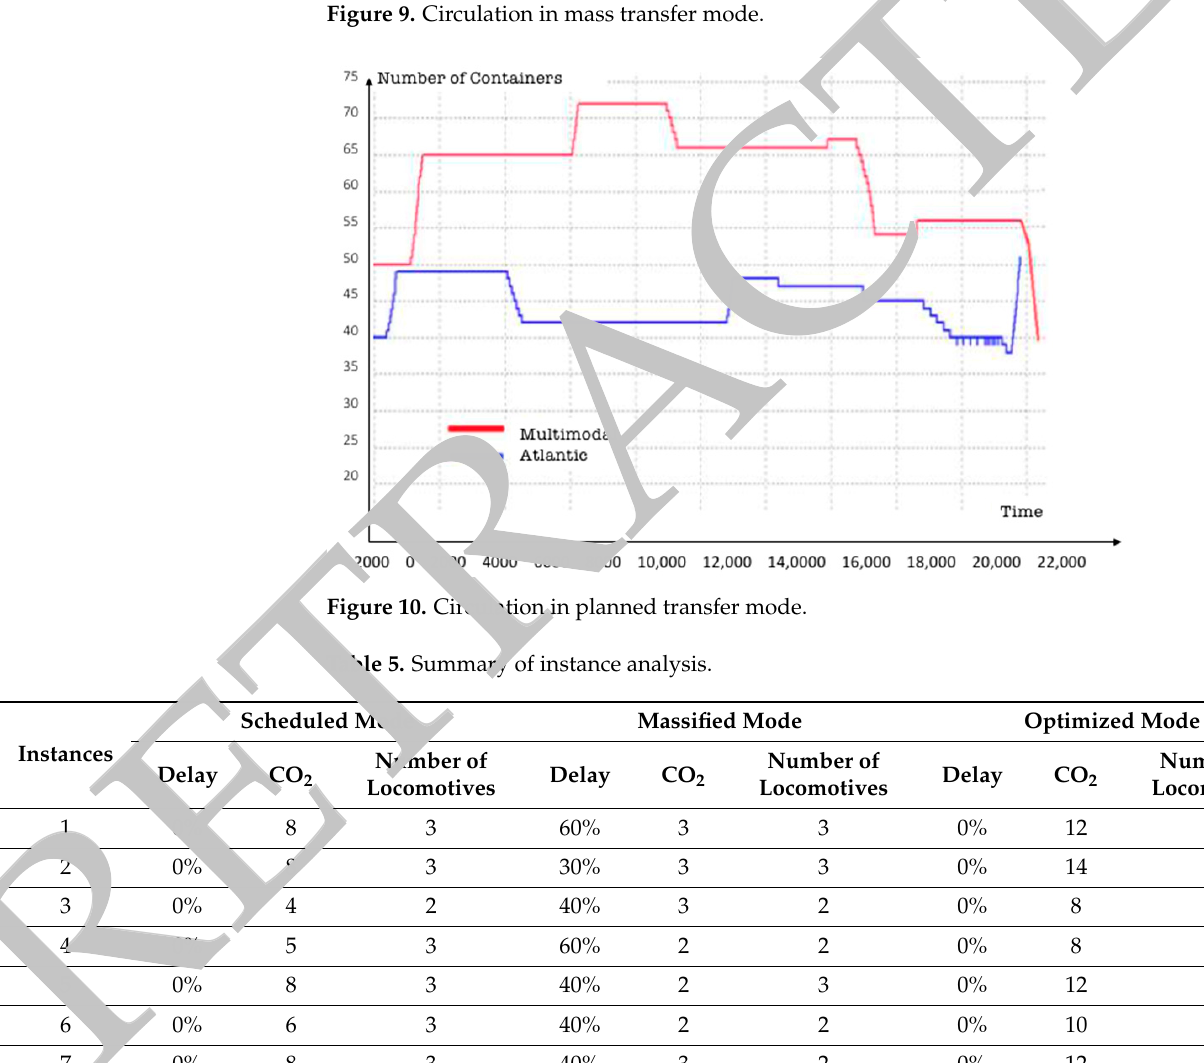
Figure 9. Circulation in mass transfer mode.